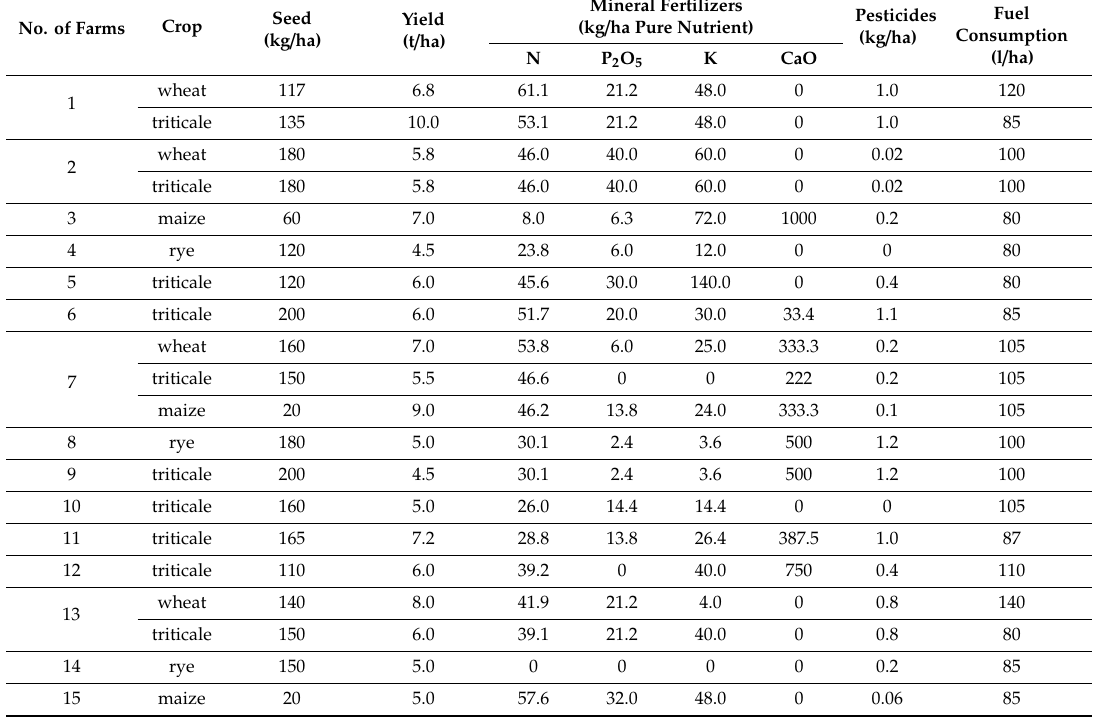
Table 2. Agricultural data based on which components of greenhouse gas (GHG) emissions have been